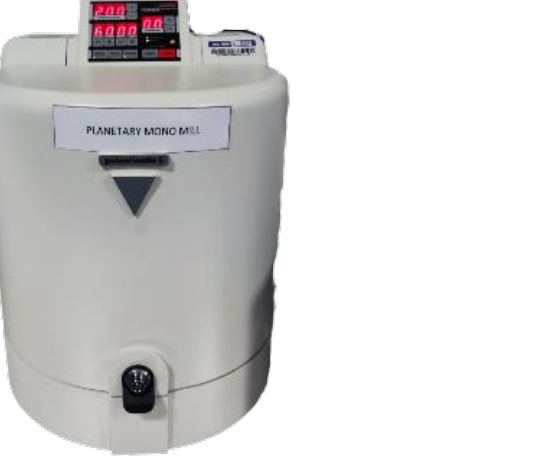
Figure 3. Planetary Mono Mill Pulverisette 6 can be used in the ball mill process.